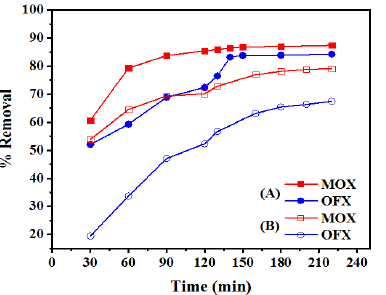
Figure 9. MOX and OFX adsorption on ( A ) Met-GO/SA (pH: 7, concentration: 20 mg/L, dosage: 0.25 g, temperature: 35 °C) and ( B ) GO/SA (pH: 7, concentration: 20 mg/L, dosage: 0.4 g, temperature: 35 °C) as a function of reaction time.